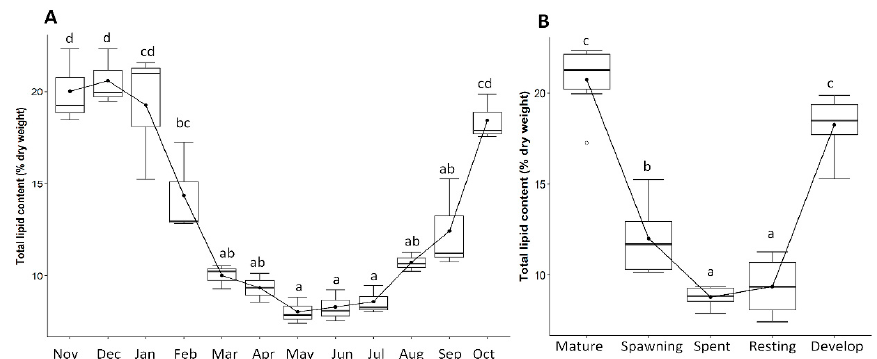
Figure 9. Box and whiskers plots of the variation of gonad lipid contents (% dry weight) of green mussel Pirna viridis during different months ( A ) and gonadal stages ( B ). Superscript letters indicate significant differences ( p < 0.05).